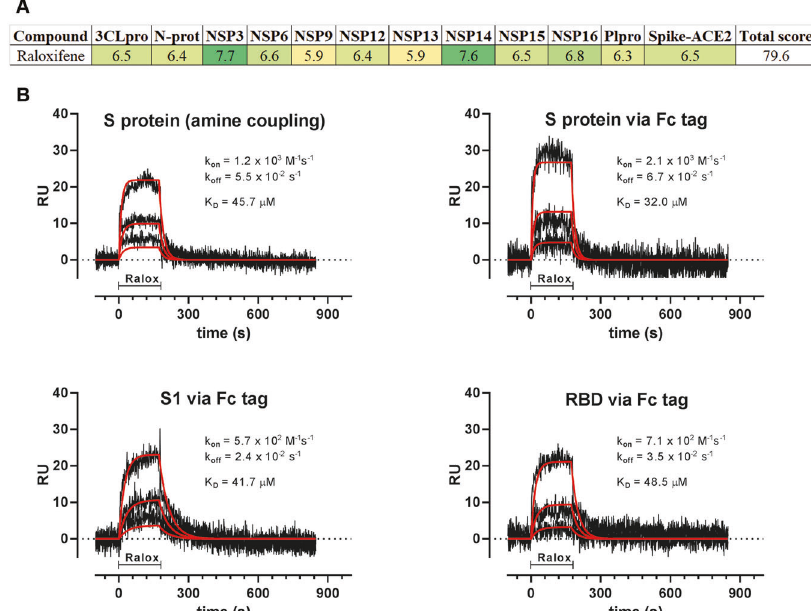
Fig. 4 Raloxifene binds SARS-CoV-2 viral proteins. A LiGen ™ docking score values that predict the binding af fi nity of the molecules in the protein binding site are reported in shades of green: dark green corresponds to higher values. Scores are also reported (the higher, the better). B SPR experiments showed that S (upper panels), S1 (lower left panel) and RBD (lower right panel) bind raloxifene. The sensorgrams (black) were obtained after subtraction of the signal observed on the reference (empty) surface, to show the speci fi c binding signal. For each target protein, the entire sensorgrams (i.e. association and dissociation phases) obtained with three raloxifene concentrations, were globally fi tted using the 1:1 Langmuir model. Red lines show the resulting fi tting while the corresponding binding parameters are shown in the insets: kon and koff are the association and dissociation rate constants, respectively, while K D is the equilibrium dissociation